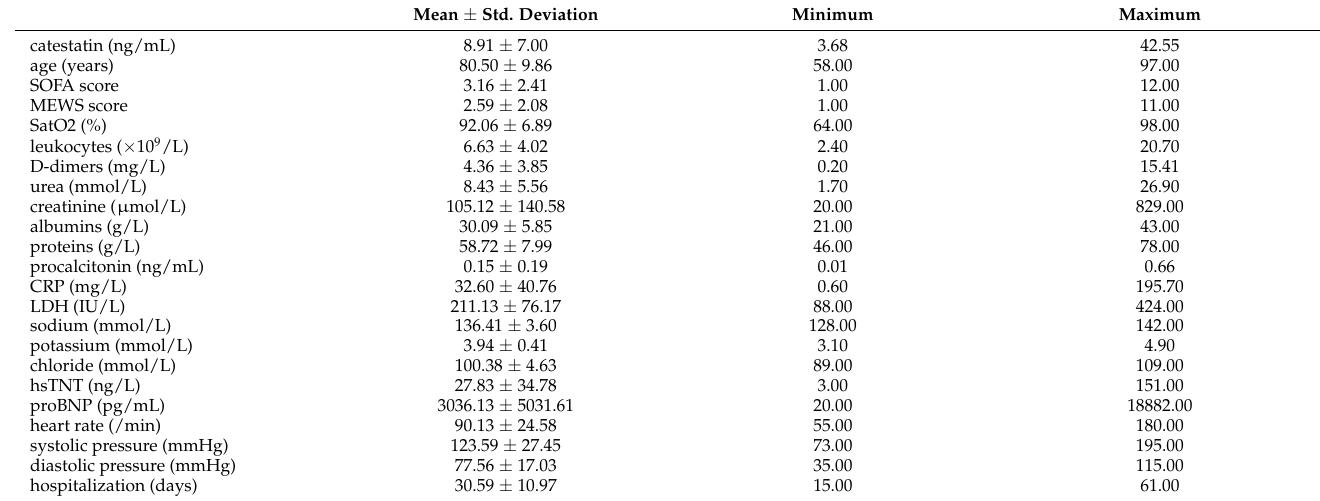
Table 1. Characteristics of the subjects ( n = 32).